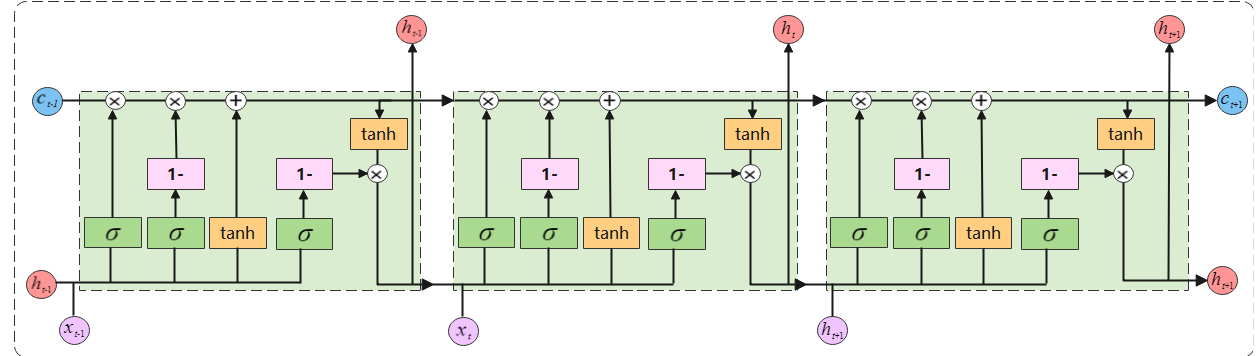
Figure 5. DSTM workflow.